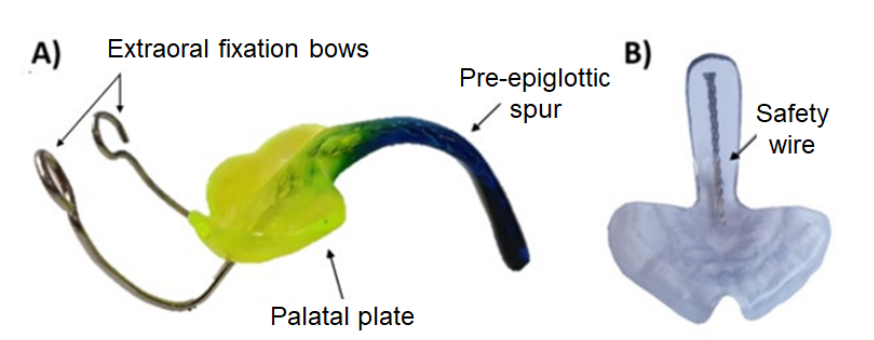
Figure 2. The Tübingen palatal plate (TPP). ( A ) An example of a finished conventional TPP with extraoral fixation bows. Custom color is added to the monomer–polymer mixture. ( B ) Printed transparent sample for showing the placement of the safety wire along the spur.